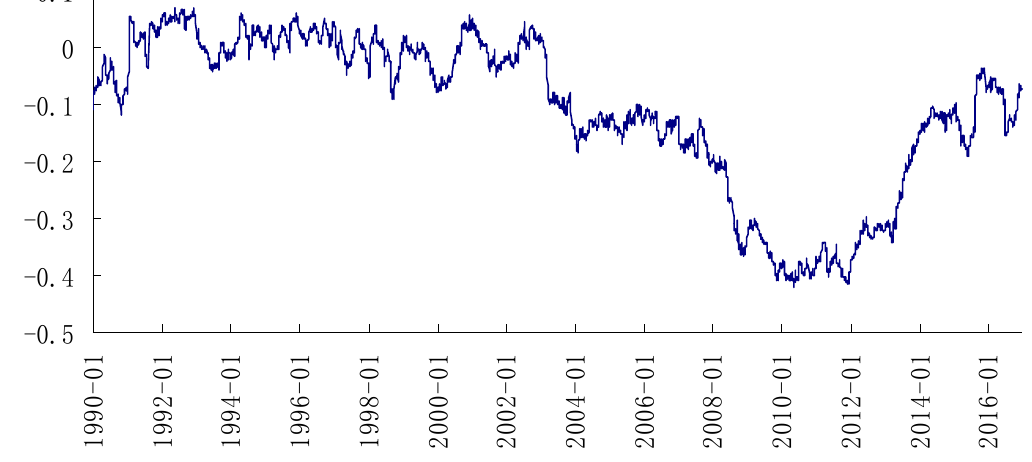
Figure 2. The dynamic conditional correlation between Brent oil price and US dollar index.